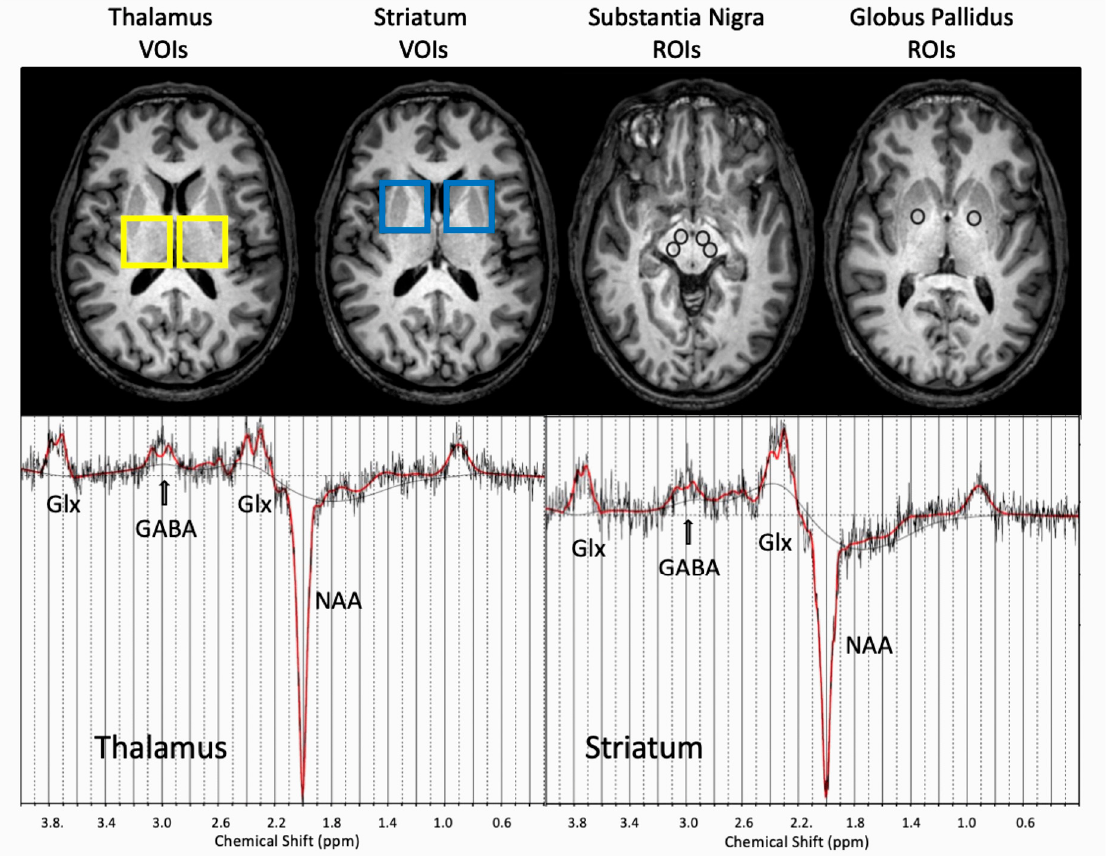
Figure 1. T1-weighted MRI images showing the placement of MRS volumes of interest (VOIs) centered on thalamus and striatum, and placement of regions of interest (ROIs) in the substantia nigra and globus pallidus for R2* analysis. Representative edited GABA spectra from the right thalamus and right striatum, indicating the LCModel fit (red solid line) with GABA, Glx, and NAA peaks shown below the MRI images. Abbreviations: T1: transverse relaxation time, MRI: magnetic resonance imaging, MRS: magnetic resonance spectroscopy, VOI: voxel of interest, ROI: region of interest, NAA: N-acetylaspartate, GABA: γ -aminobutyric acid, Glx: combined signal of glutamate and